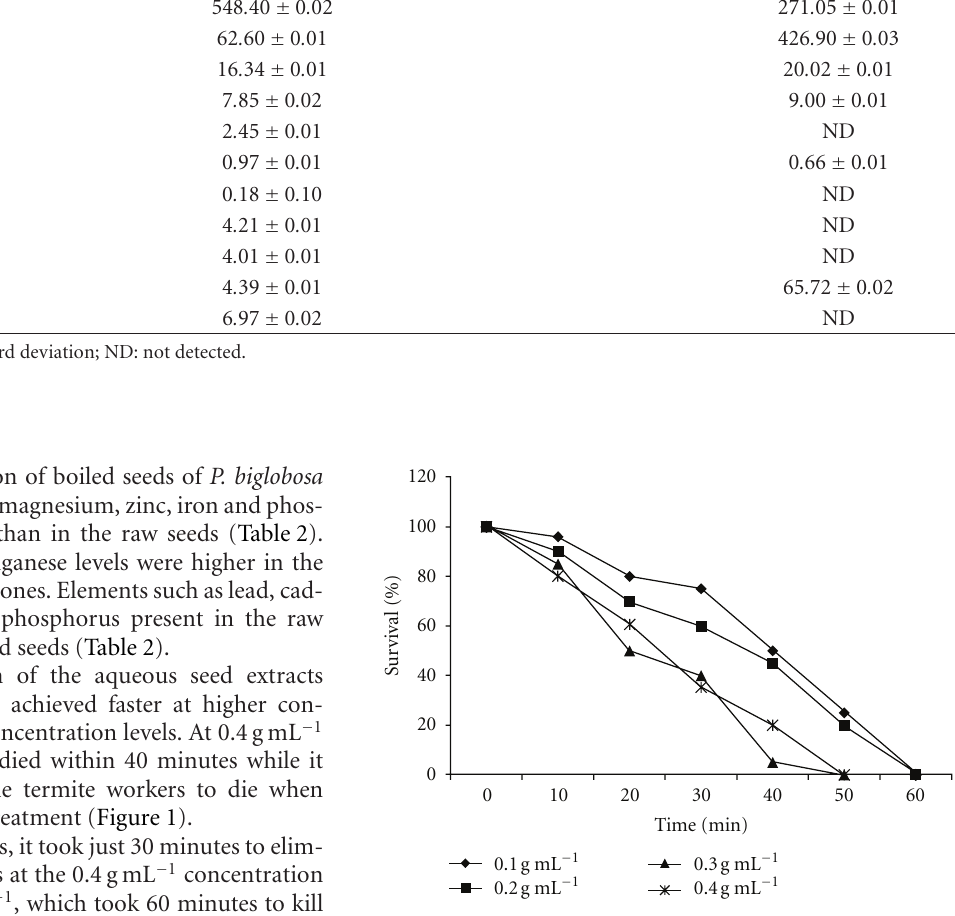
Figure 1: Antitermitic activity of aqueous extracts of Parkia biglo- bosa